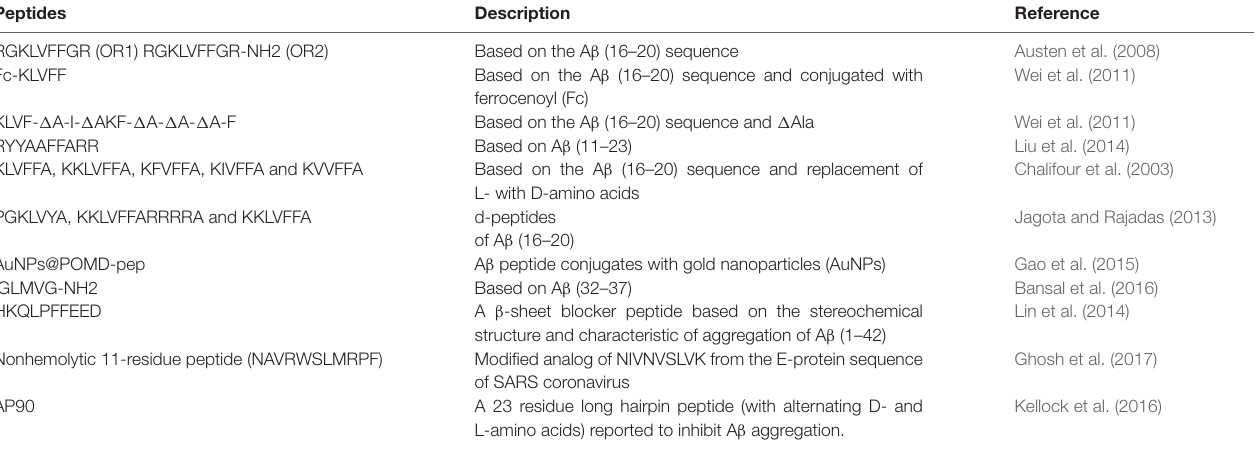
TABLE 1 | List of peptide-based inhibitors reported to be effective against Alzheimer’s disease (AD). Peptides